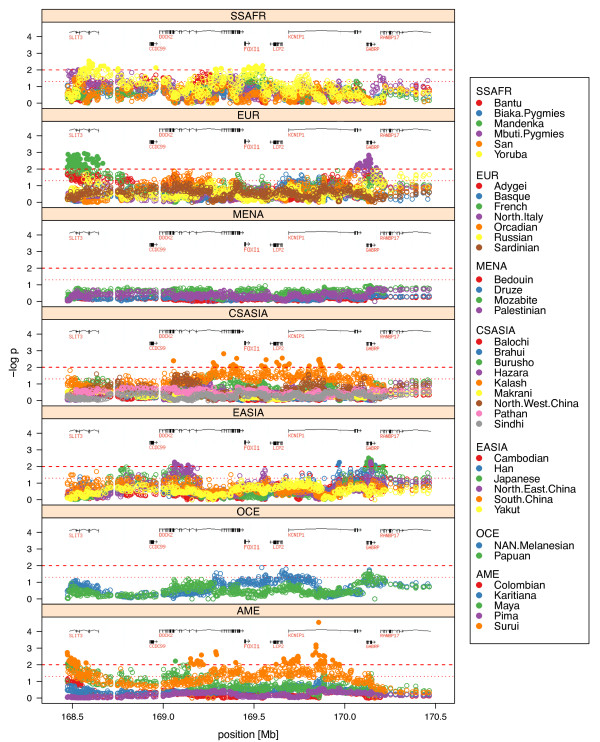
Distribution of -log p-values for XP-Rsb across 39 HGDP-CEPH populations grouped into major geographical regions. The genome-wide significance of the XP-Rsb statistic per SNP site and population is plotted against distance over 2 Mb flanking the FOXI1 gene. Location of genes is shown on top of each plot. Dotted and dashed lines show 0.05 and 0.01 significance levels, respectively. Values below 0.01 significance level are additionally represented with solid color circles. Populations are shown according to their continental groups: Sub-Saharan Africa (SSAFR), Europe (EUR), Middle East-North Africa (MENA), Central-South Asia (CSASIA), East Asia (EASIA), Oceania (OCE) and America (AME).